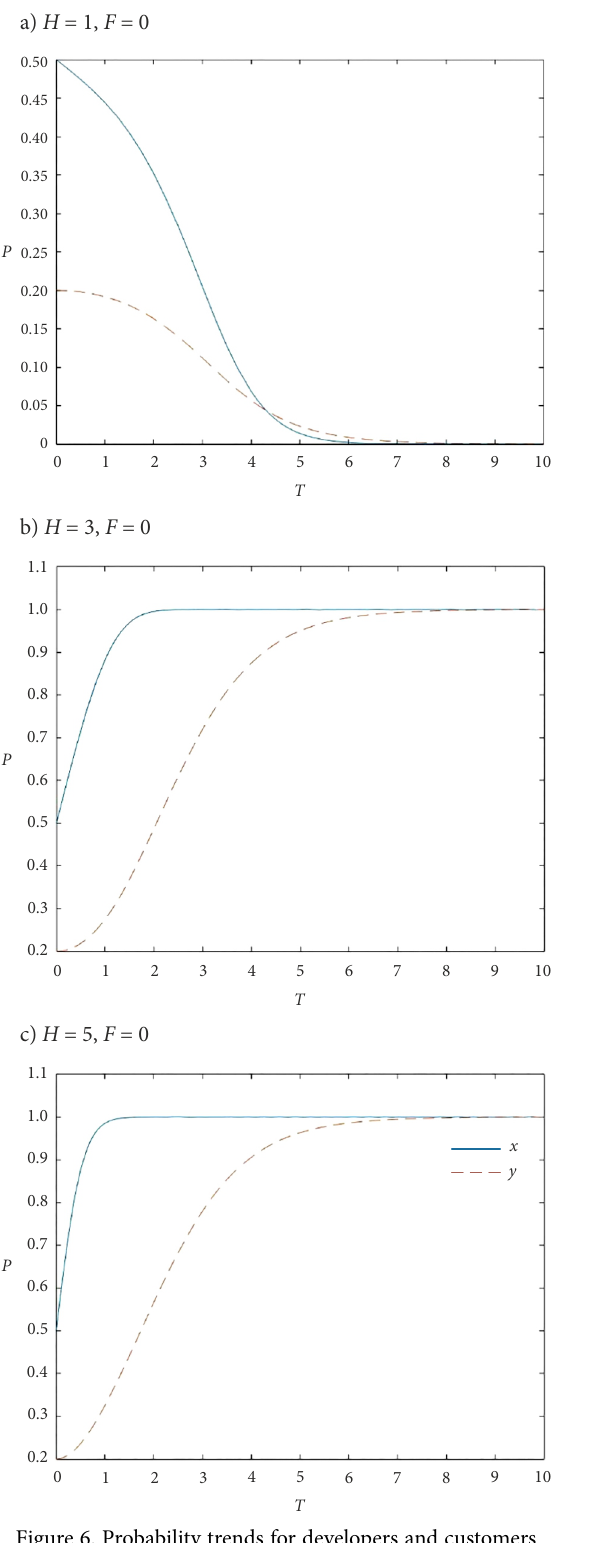
Figure 6. Probability trends for developers and customers Figure 7. Probability trends for developers and